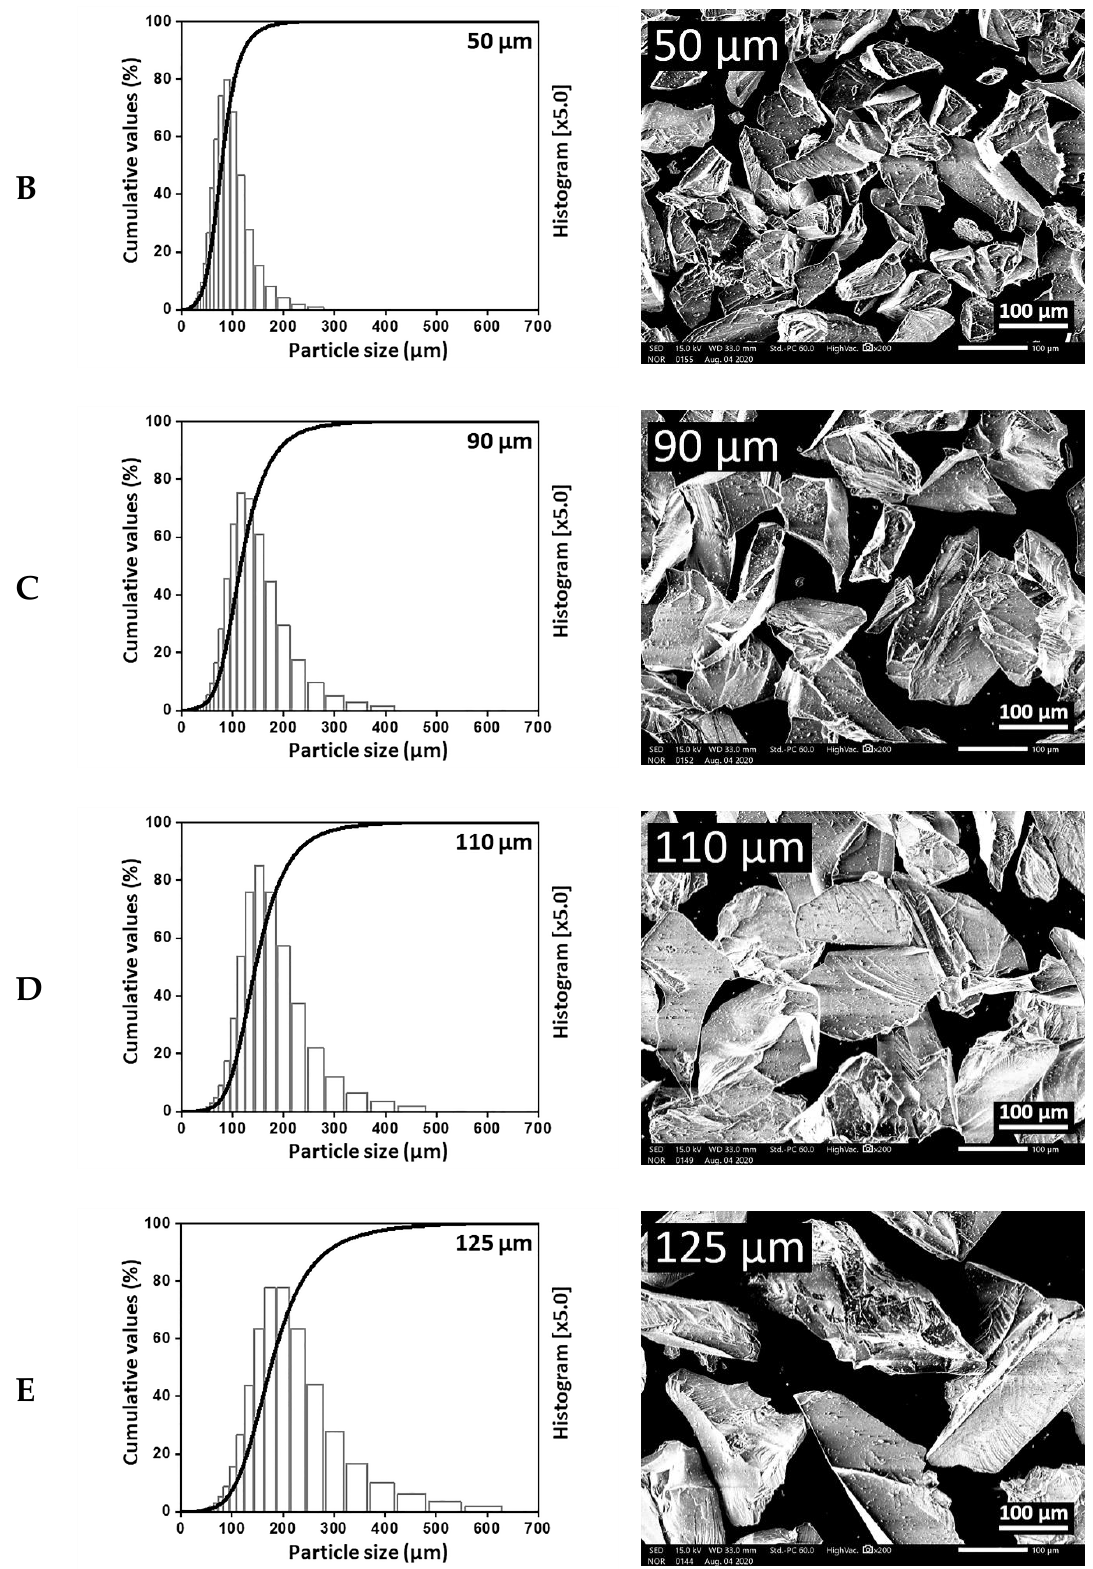
Figure 3. Particle size distributions and scanning electron micrographs of Al 2 O 3 particles. The finest particles were observed in the 25 µ m specification, while the largest particles prevailed in the 125 µ m specification. Most of the particles had a grit shape with sharp edges and rarely a spherical shape. ( A ) 25 µ m specification; ( B ) 50 µ m specification; ( C ) 90 µ m specification; ( D ) 110 µ m specification; ( E ) 125 µ m